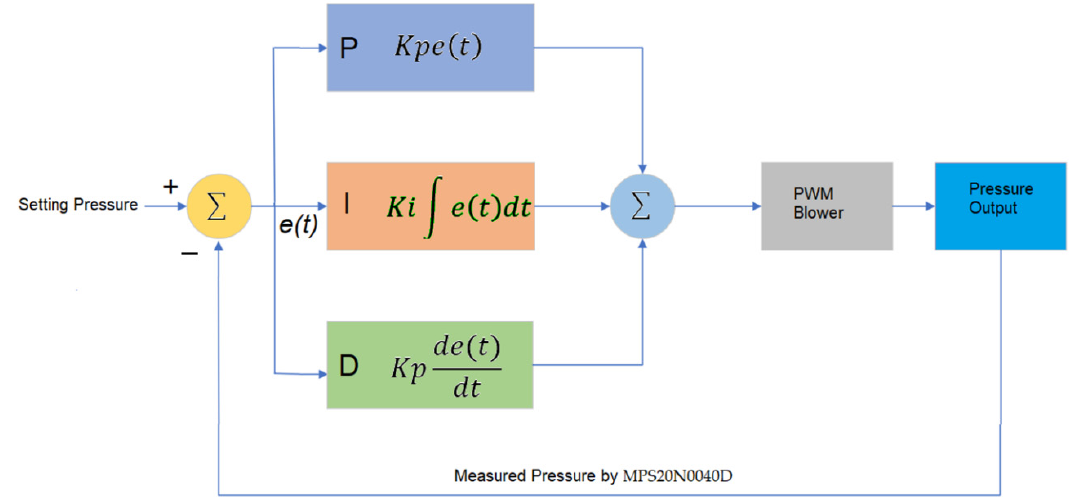
Figure 15. PID pressure control.